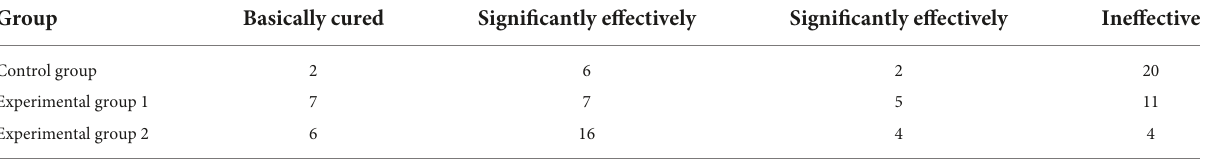
TABLE 7 Clinical efficacy of control group and experimental group. Group Basically cured Significantly effectively Significantly